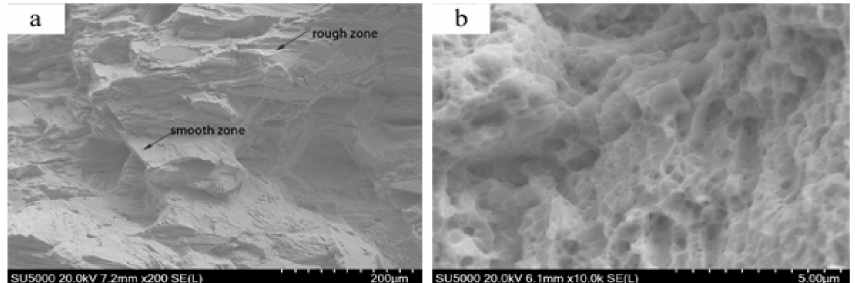
Figure 15. Micrographs of fracture surfaces of tensile specimens containing 5% Al 2 O 3 : ( a ) fracture surface of tensile specimens and ( b ) the magnified fracture surface in Figure